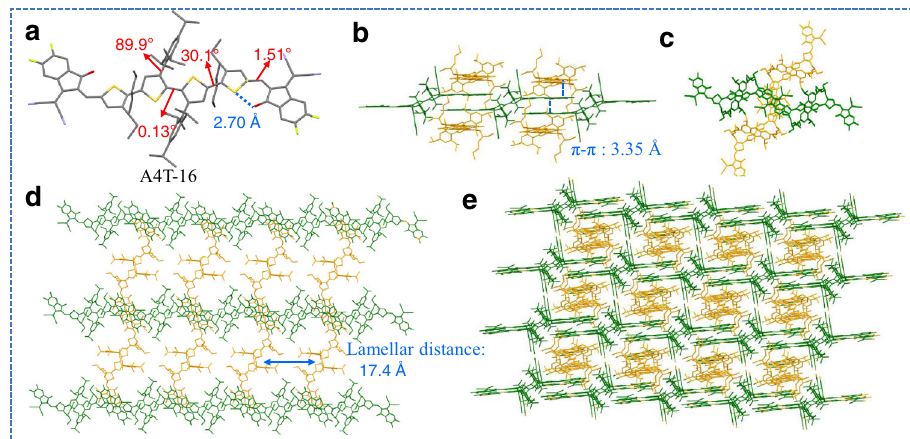
Fig. 3 Single-crystal structure of A4T-16. a Single-crystal structure of A4T-16. b Molecules packing viewed from the x − z plane. c Molecules packing viewed from the x − y plane. d The top view of the network structure of A4T-16. e 3D interpenetrating network structure of A4T-16.